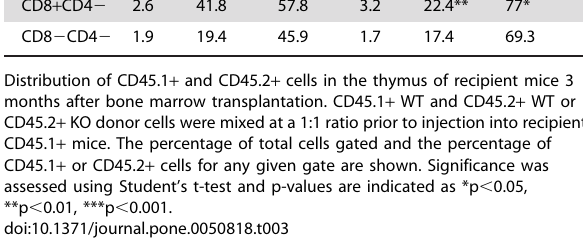
Distribution of CD45.1 + and CD45.2 + cells in the lymph node of recipient mice 3 months after bone marrow transplantation. CD45.1 + WT and CD45.2 + WT or CD45.2 + KO donor cells were mixed at a 1:1 ratio prior to injection into recipient CD45.1 + mice. The percentage of total cells gated and the percentage of